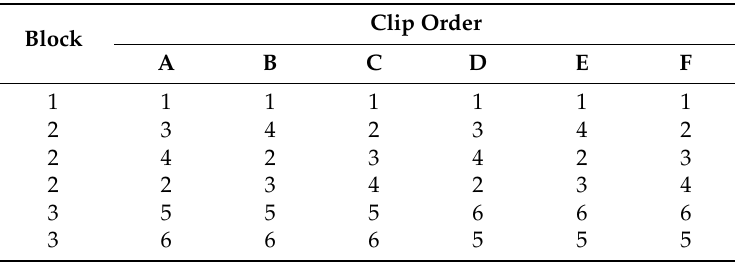
Table 4. Each of the six clip